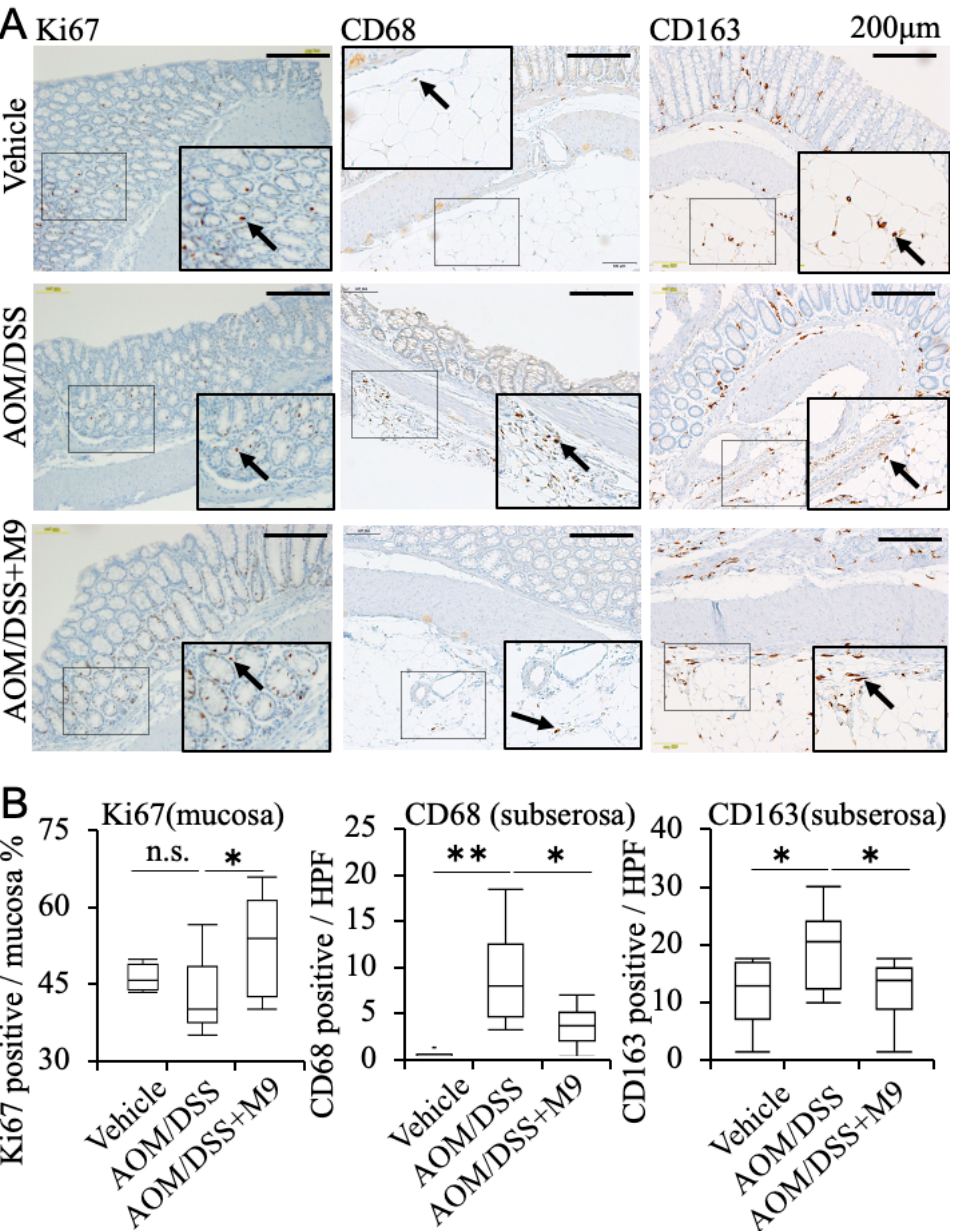
Figure 4. The expression of selected molecules in an AOM/DSS-induced mouse model of colitis- associated cancer. ( A ) Representative image of immunohistochemistry staining for Ki67, CD68, and CD163 in the non-tumor areas (arrows). Positive signals for Ki67 in cell nuclei were detected, and both CD68 and CD163 markers were observed in the cell cytoplasm. ( B ) The percentage of Ki67+ staining in the mucosal cell nucleus was scored. The number of cells positive in the subserosa per high power field (HPF: 0.196 mm 2 ) was counted and summarized in graphs. n = 10. * p < 0.05; ** p < 0.01. Scale bar: 200 µ m. n.s. means not significantly error.